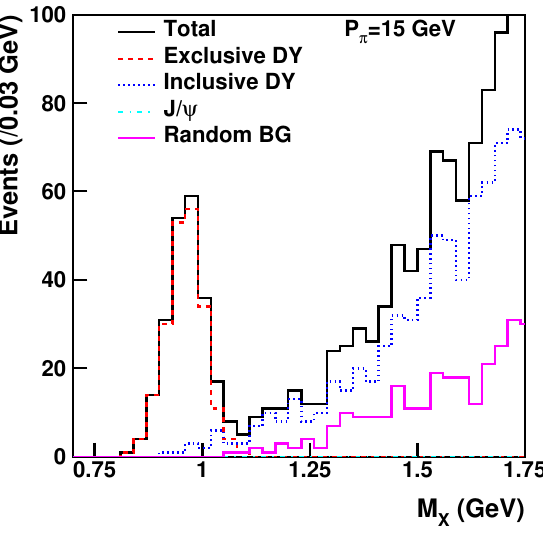
Figure 15. Monte Carlo simulation for the missing-mass, M X , spectra of the µ + µ − events at the pion momentum, p π = 15 GeV/ c